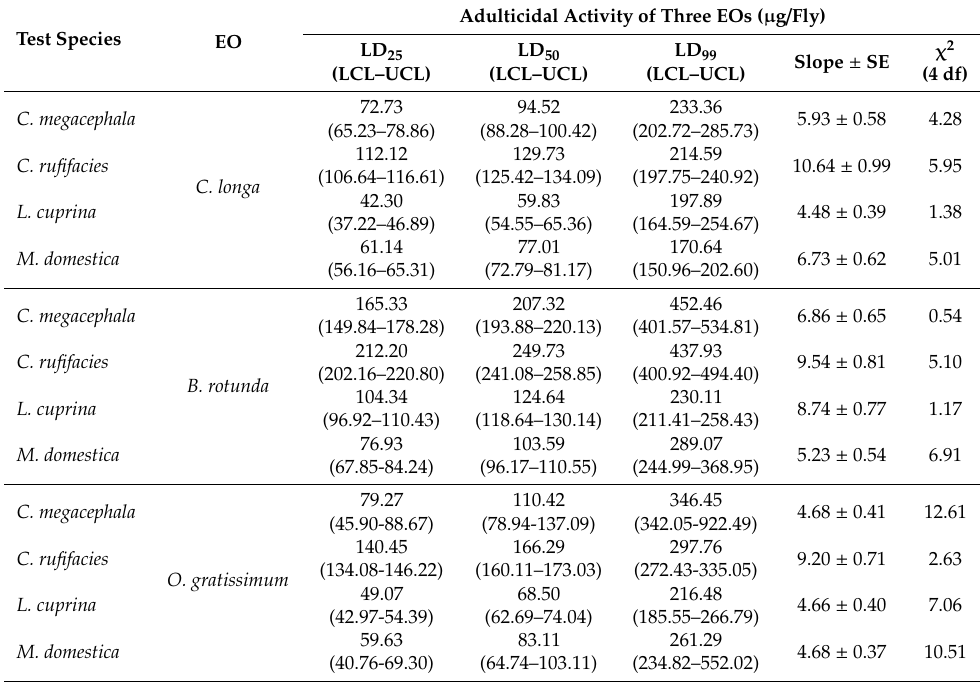
Table 5. The adulticidal activity of three EOs against the blow flies and the house fly. Test Species